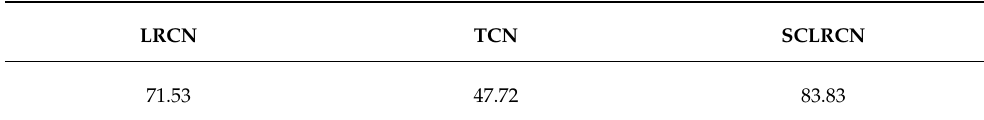
Table 3. Averaged test accuracy (%) of each